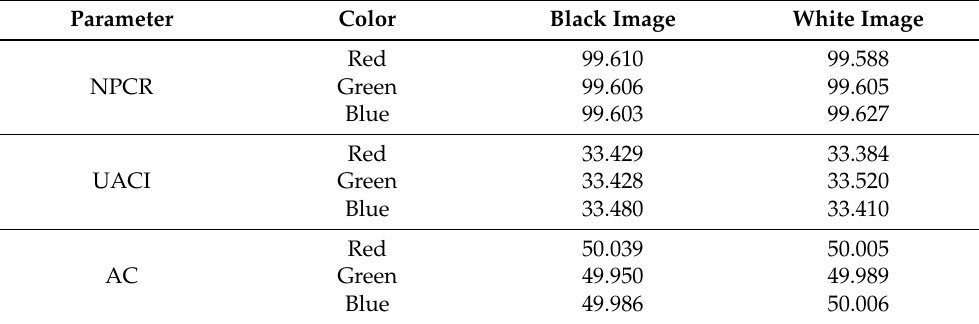
Table 13. NPCR, UACI and AC values for the completely black and completely white